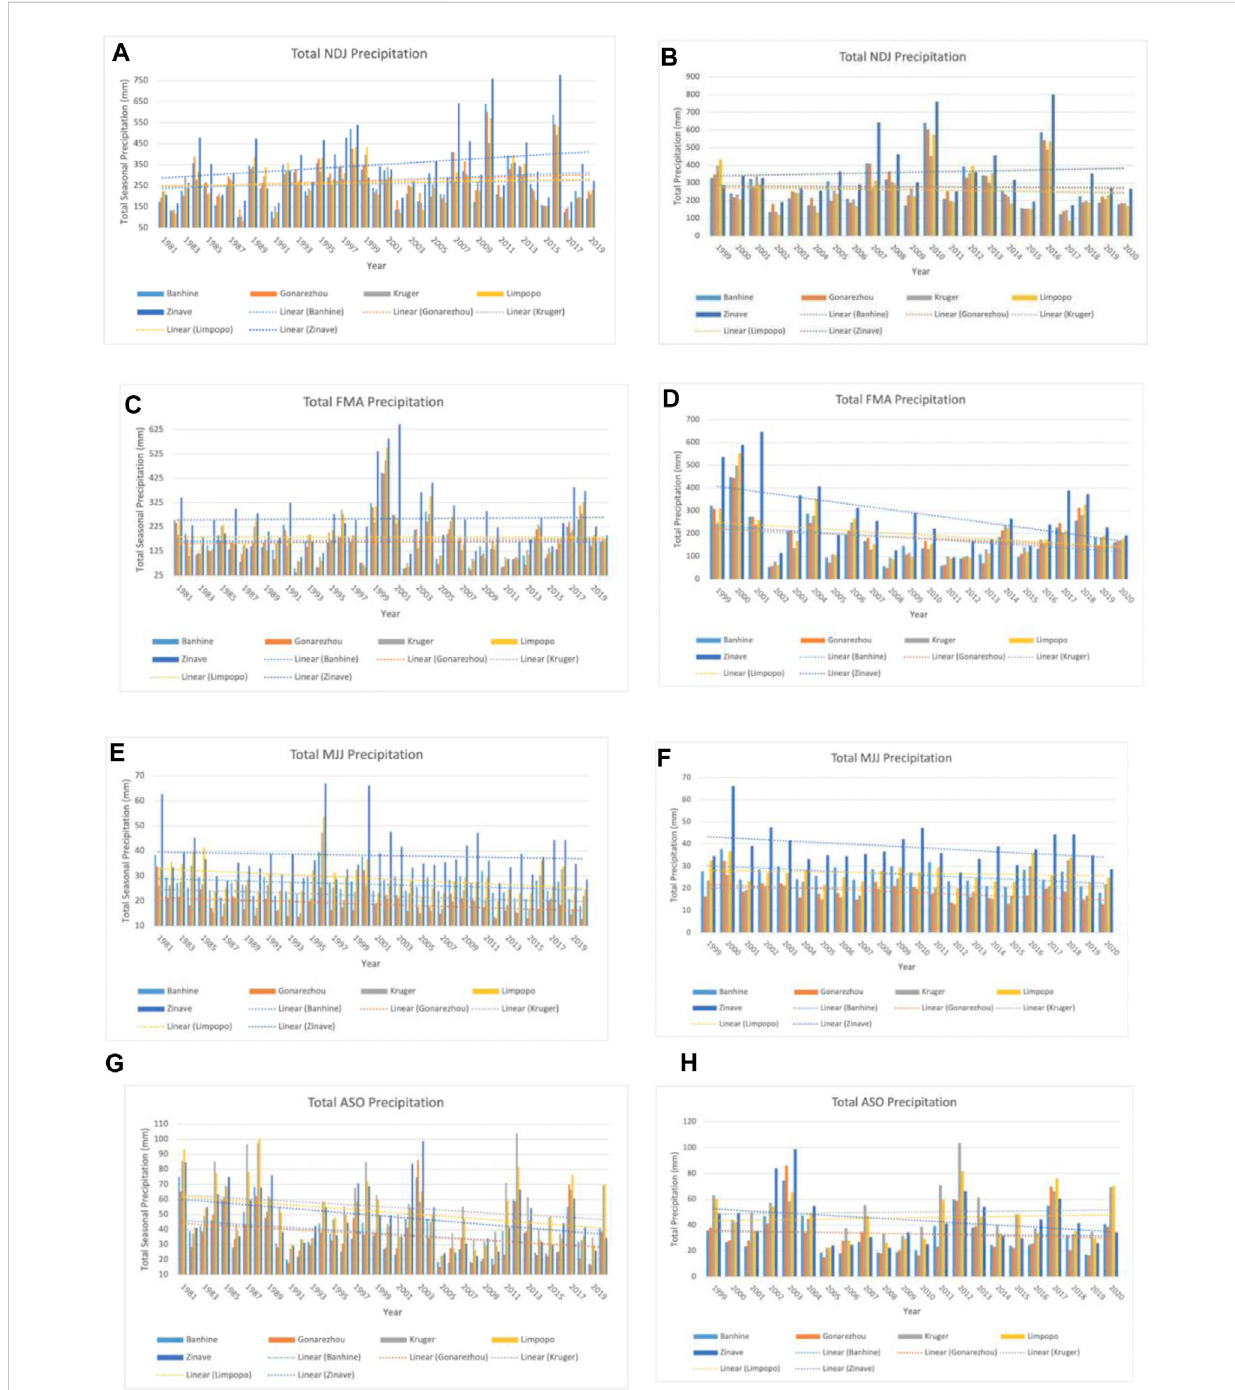
FIGURE 3 Total seasonal precipitation (mm) by national park from 1981 to 2020 demonstrating longer-term climate. Precipitation is lagged 1 month from vegetation: NDJ, November, December, January for (A) 1981 – 2020 and (B) 2000 – 2020; FMA, February, March, April for (C) 1981 – 2020 and